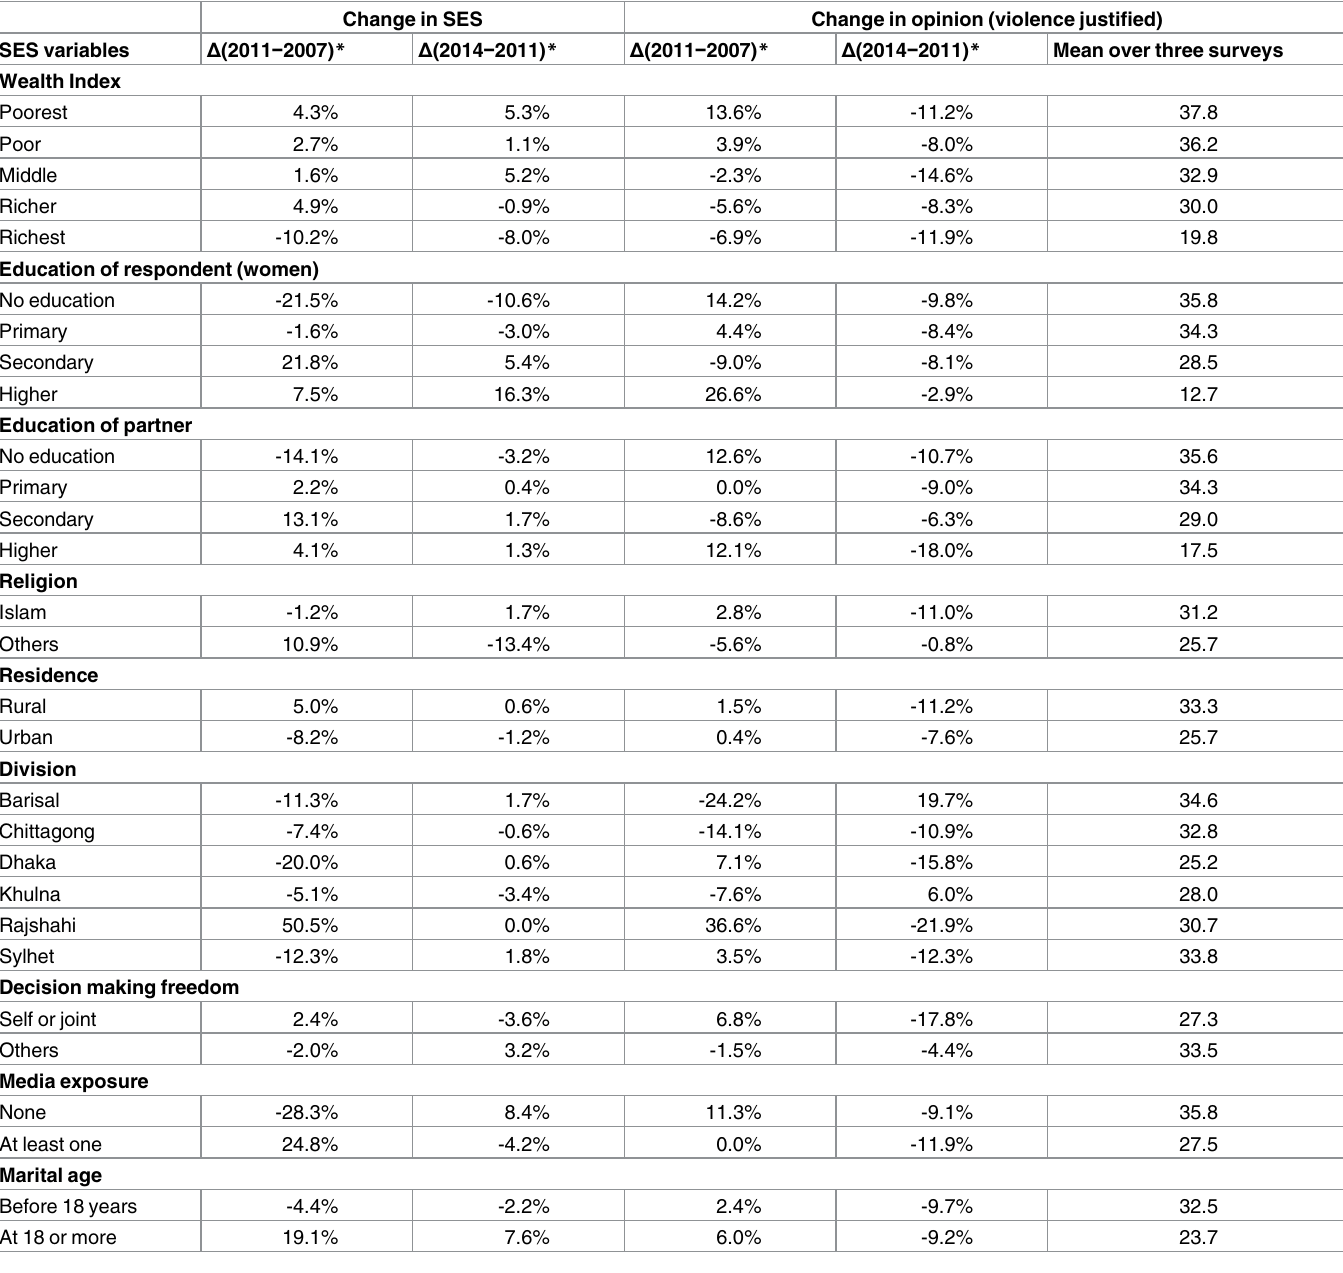
Table 3. Binary logistic model fitted with household SES to women’s opinion regarding physical spousal violence justification. Change in SES Change in opinion (violence